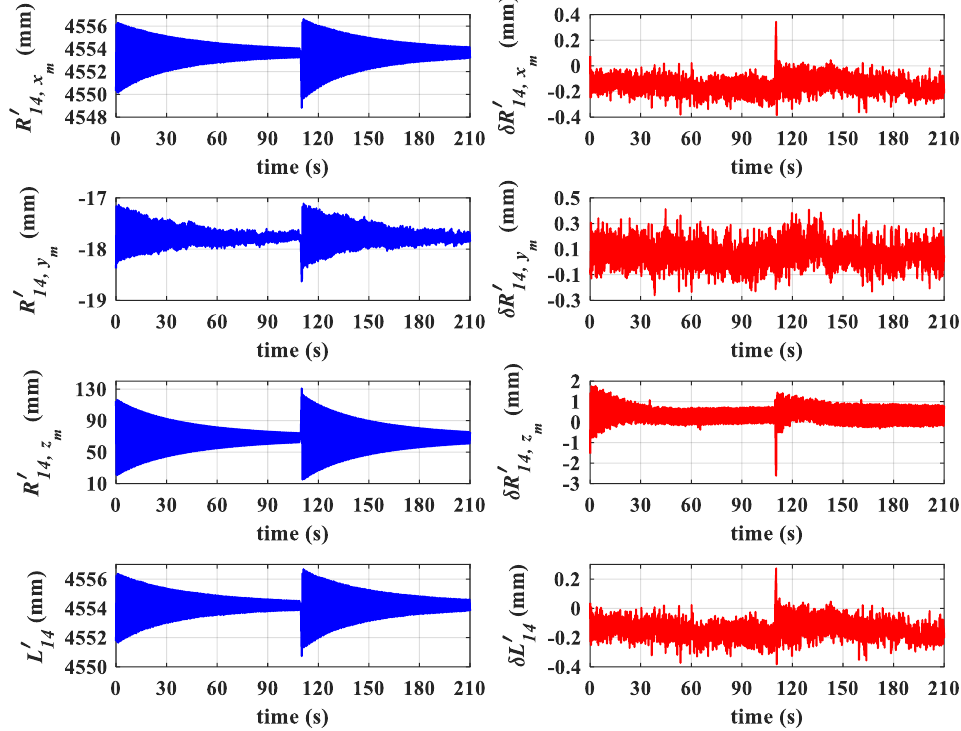
Figure 12. Measured values and errors of relative position and baseline length between antennas 1 and 4.